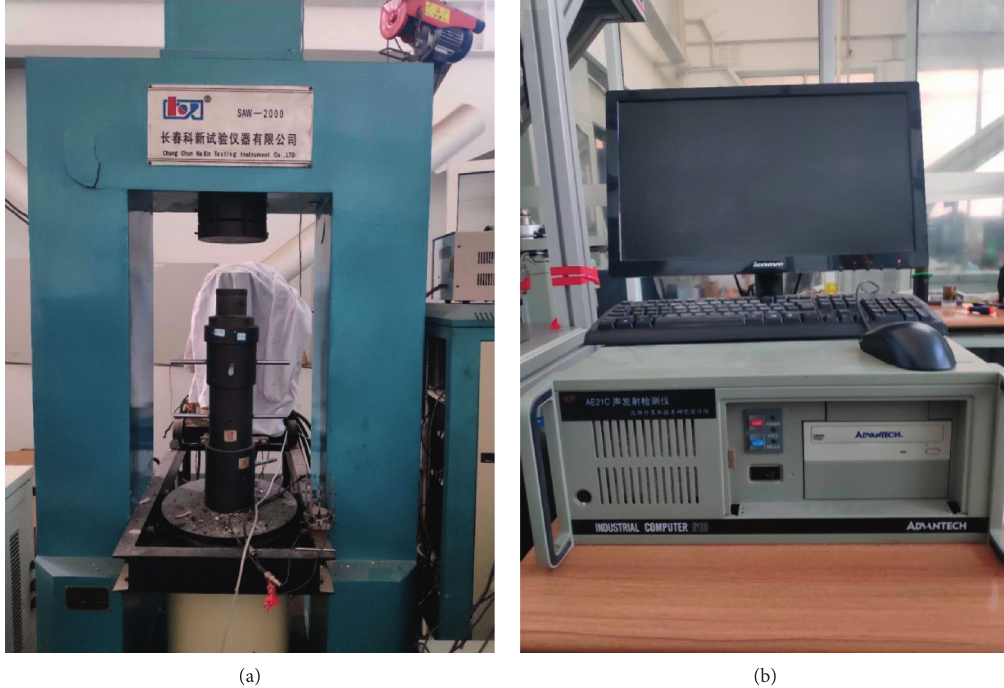
Figure 3: Test equipment. (a) Saw-2000 microcomputer-controlled electrohydraulic servo rock triaxial pressure testing machine. (b) AW21C acoustic emission